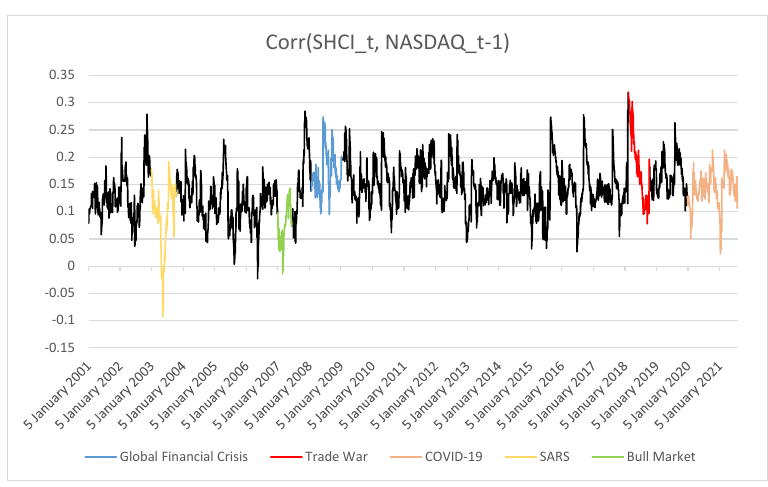
Figure 7. Dynamic correlation between SHCI at t and NASDAQ at t − 1.